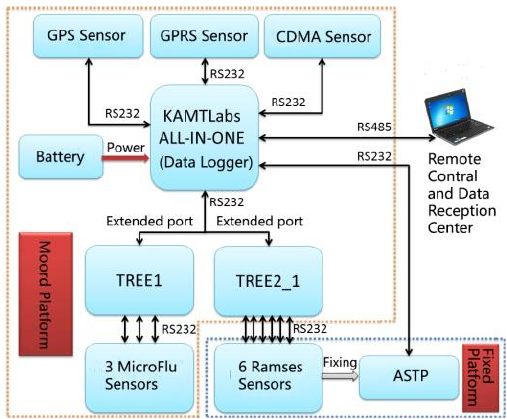
Figure 3. The diagram of the system design of the AFWCPOS (Automatic Stationary Water Color Parameters Observation System). The stationary platform is for spectra measurements, and the moored one is for the data logger and power supply. In addition, the automatic sun-tracking platform (ASTP) is an automatic sun-tracking platform. (GPS: Global Positioning System; GPRS: General Packet Radio Service; CDMA: Code Division Multiple Access; KAMTLabs: Labs of Kaner Application